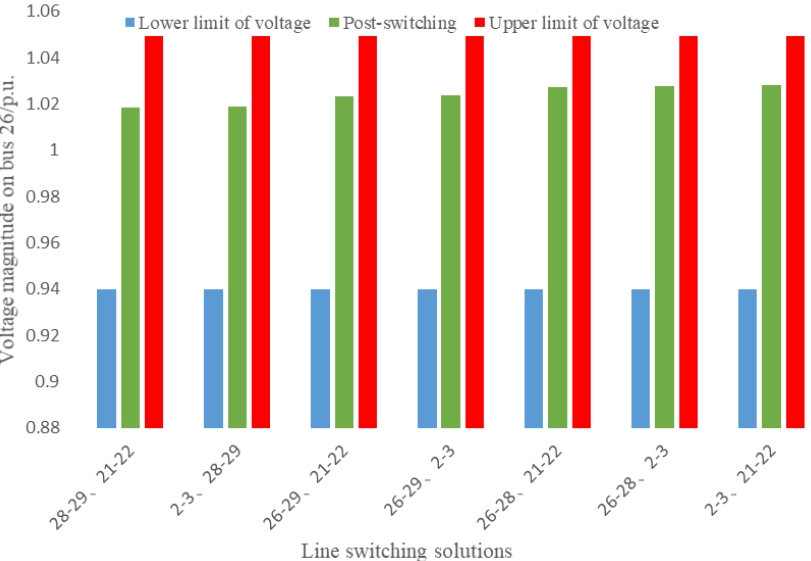
Figure 9. The voltage of bus 26 for the pre-switching and post-switching systems.